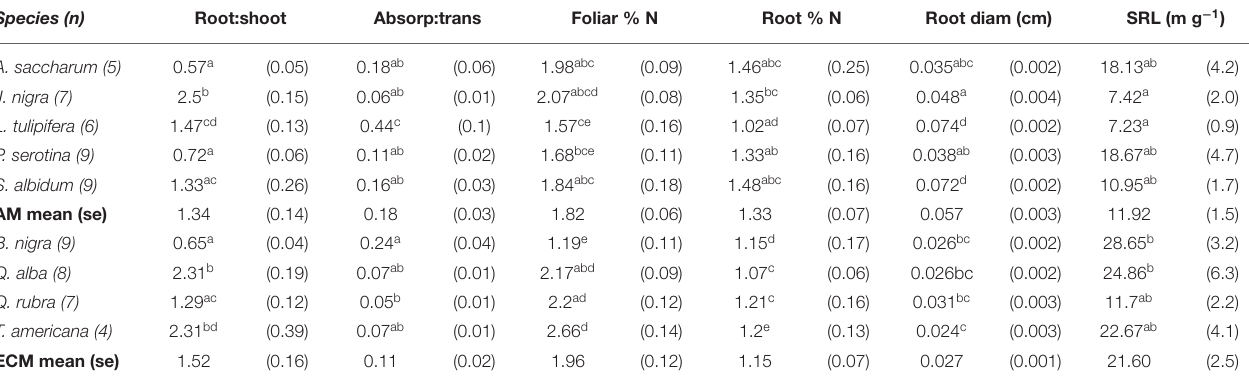
TABLE 1 | Species-specific differences in root mass: shoot mass, absorptive root mass: transport root mass, foliar and root % N, absorptive root diameter, and specific root length (SRL). Species